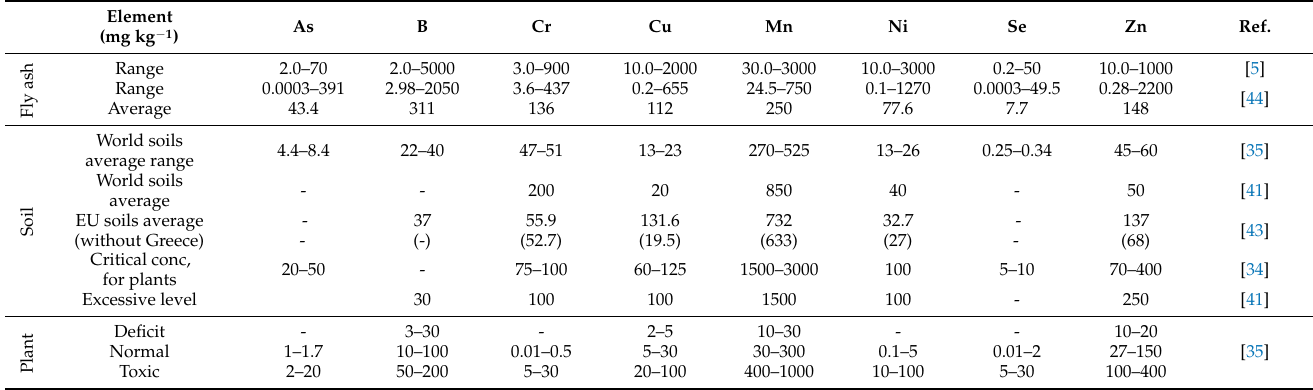
Table 6. Threshold and average concentrations of the analysed heavy metal(loid)s in fly ash, soils and plant